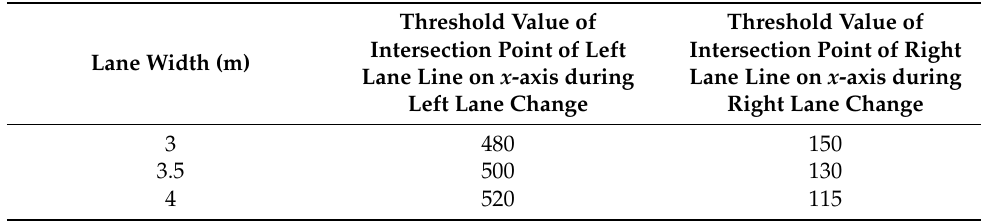
Table 3. Threshold value of intersection at different lane